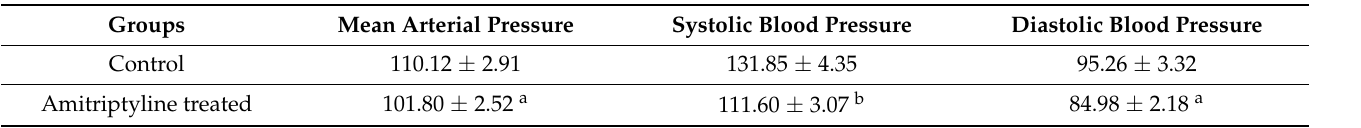
Table 1. Mean arterial pressure, systolic and diastolic blood pressure of control, and amitriptyline treated animals (mmHg). Control (n = 21) and amitriptyline treated (n = 21). Mean ± standard deviation